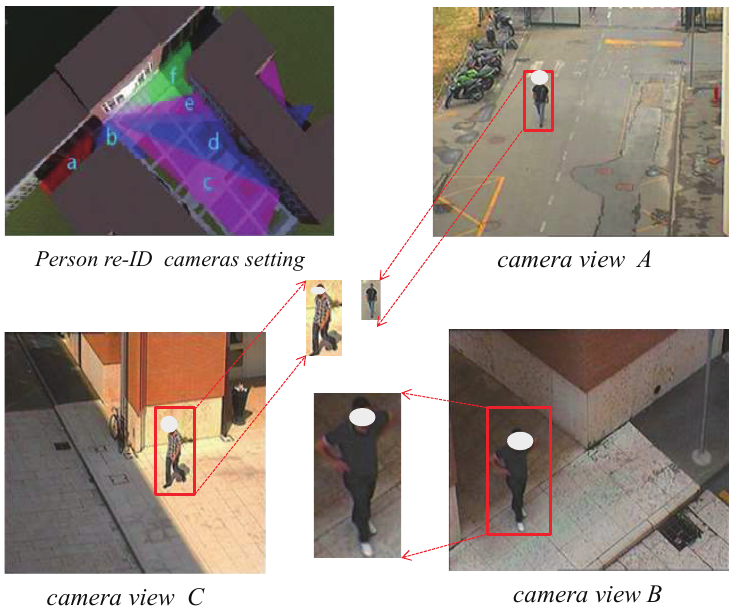
Figure 1. The real surveillance scenes for the person re-ID application. There are multiple camera views for the same person with different representations that are in great variations in illumination (camera C), scales (camera A), and person poses (camera B) in harsh real-world